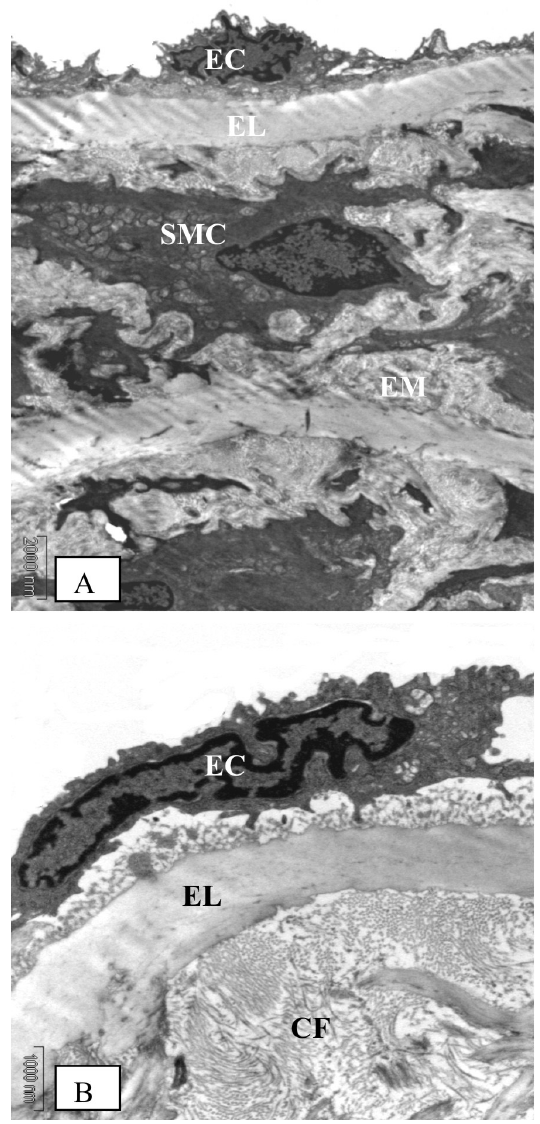
Figure 3 - Electron microscopic findings on the aorta of control rats at eight weeks of study. (A) (Original magnification x 4400) The media layer is composed mainly of smooth muscle cells (SMC) with normal appearance, elastic lamina (EL) and extracellular matrix (EM) between the elastic lamina and smooth muscle cells. (B) (Original magnification x 11000) Extracel- lular matrix contains scattered collagen fibers (CF) and the endothelial cells appear